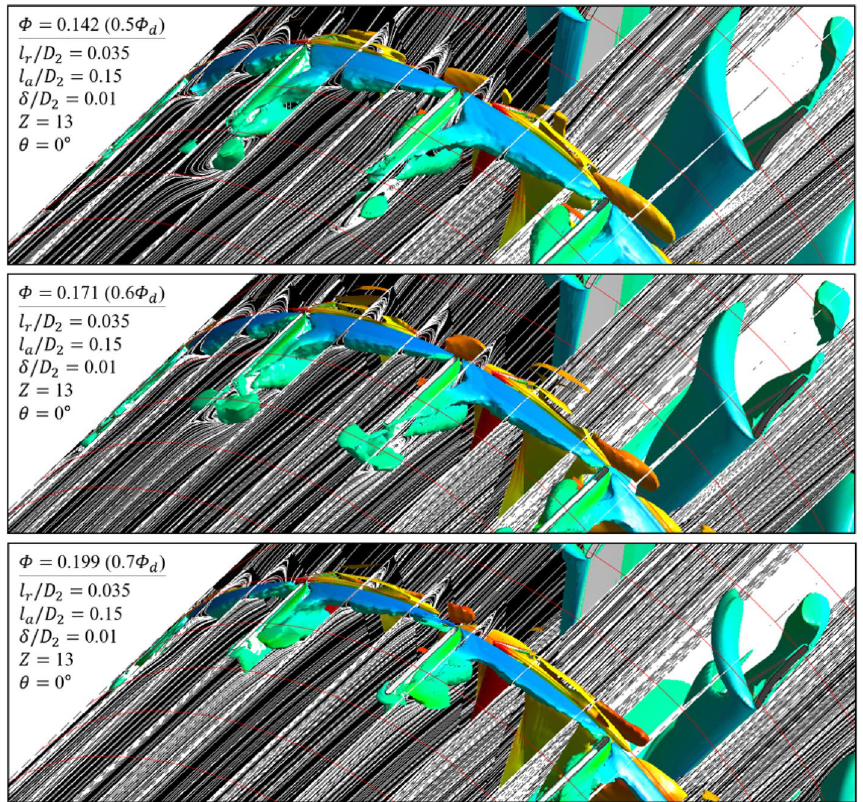
Figure 13. Internal flow field with limiting streamlines and Q -criterion for case of ASF attached (0.5–0.7 Φ d ); anti-stalling